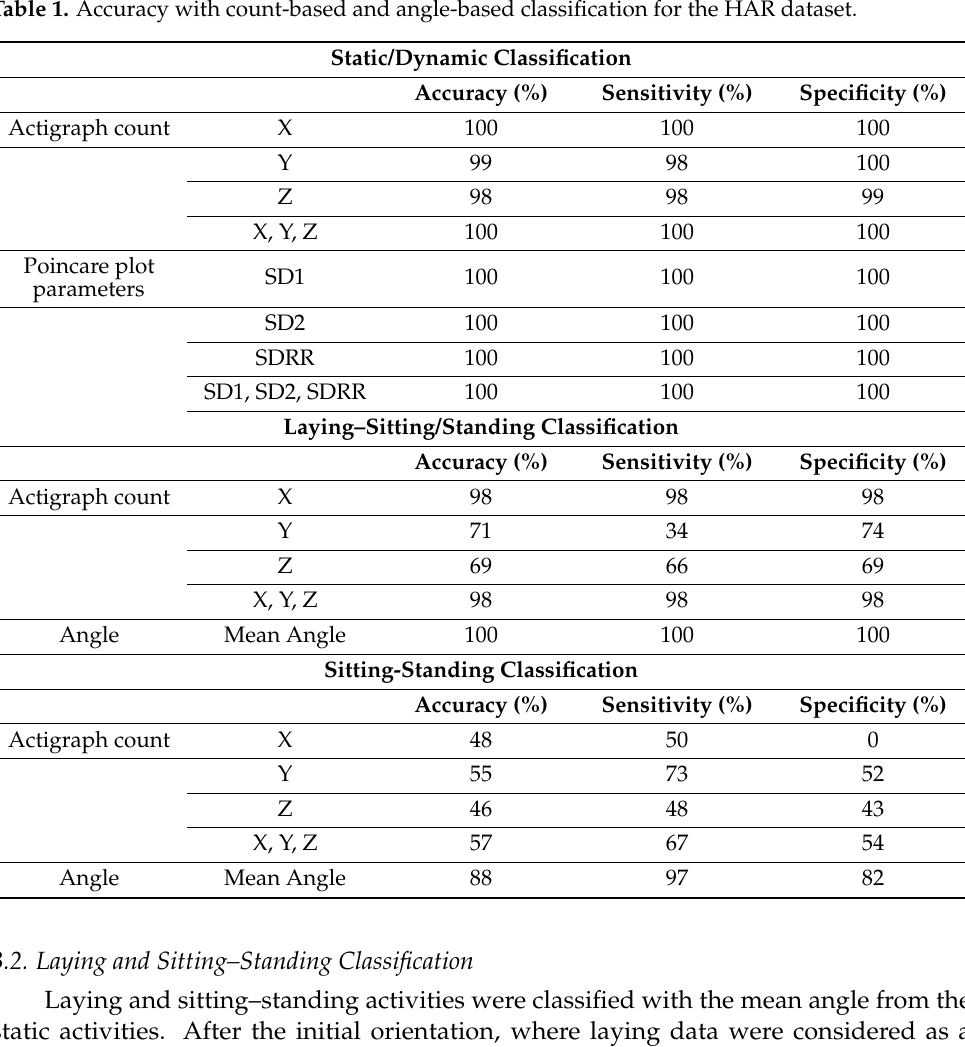
Table 1. Accuracy with count-based and angle-based classification for the HAR dataset.